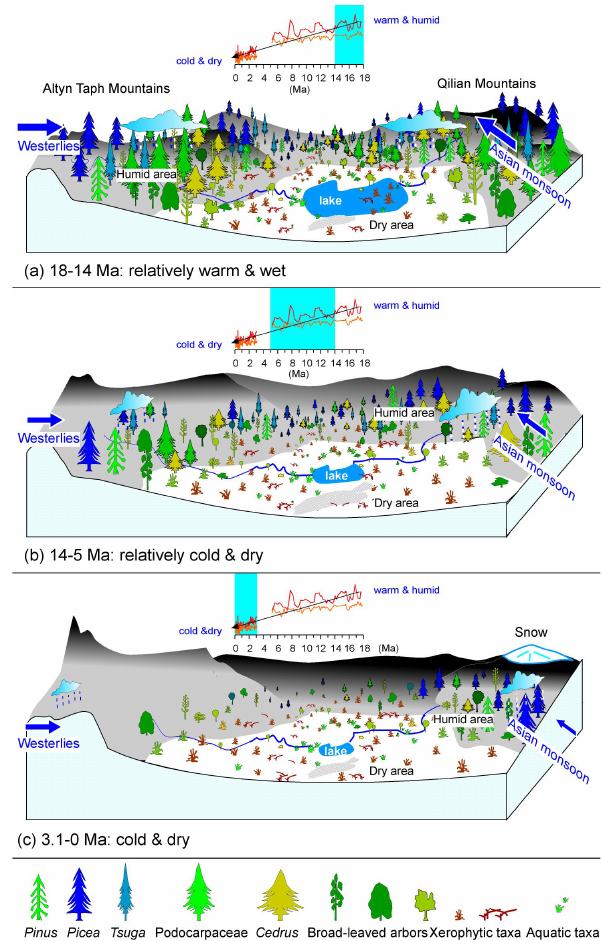
Fig. 11. Cartoon illustrating the vegetation, paleoclimates, and pale- oaltimetry of the Qaidam Basin during (a) 18–14Ma, (b) 14–5Ma, and (c) 3.1–0Ma (blue rectangle showing the corresponding climate background according to the compiled pollen